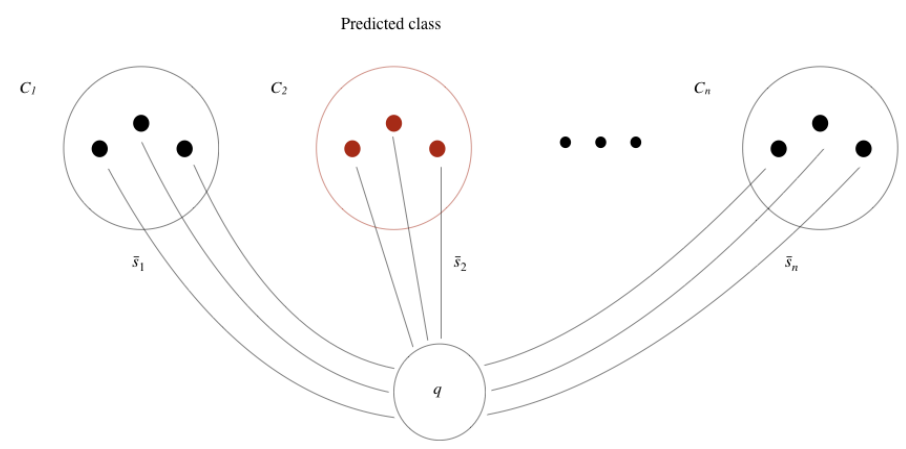
Figure 8. Classification of a new image q , given n reference sets, each with three